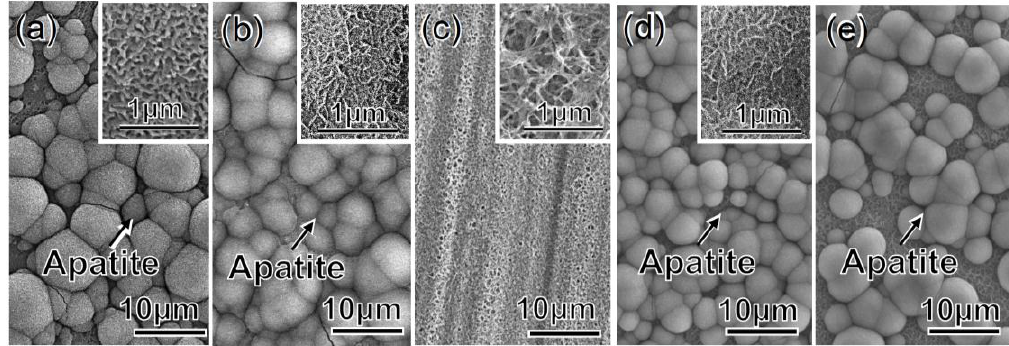
Figure 7. FE-SEM photographs of surfaces of Ti soaked in SBF for 3 days following ( a ) NaOH, 100Ca + 0.05Ga and heat treatments, and finally ( b ) water treatment, or ( c ) NaOH, 100Ga and heat treatments and finally ( d ) water treatment. Apatite formation of Ti subjected to the treatment of ( d ) followed by a storage under 95% relative humidity at 80 °C for 7 days is shown in ( e ). The insets in ( a – d ) show high-magnification images.